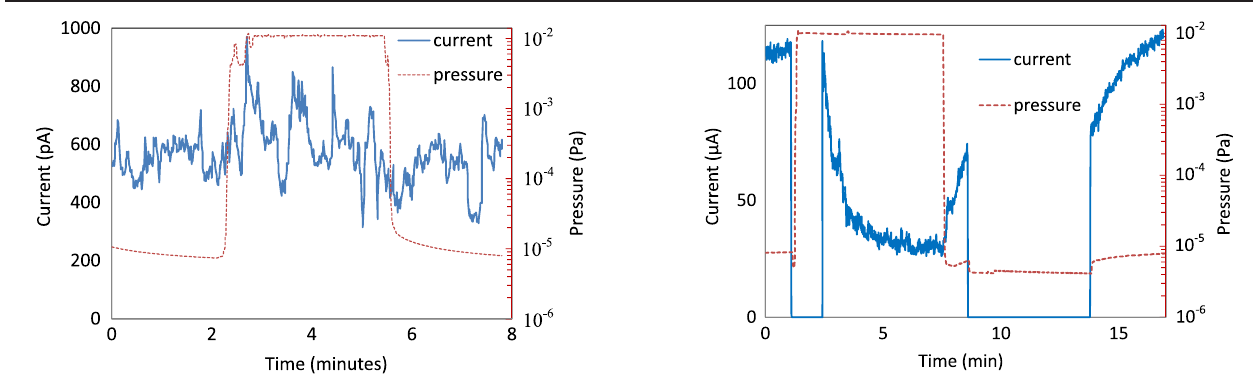
FIG. 5. Field emission current with nitrogen injection: 2 cm gap distance, 11 kV applied voltage.